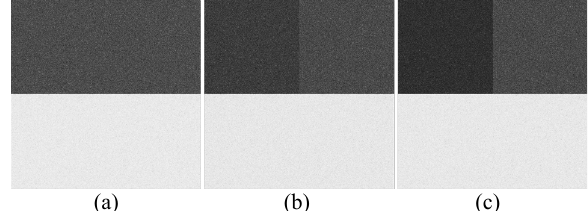
Figure 2 . SAR change detection images of the simulated SAR γ . image pairs using different coherence estimators. (a) ˆ c γ . (b) ˆ m γ (c) Proposed ˆ w